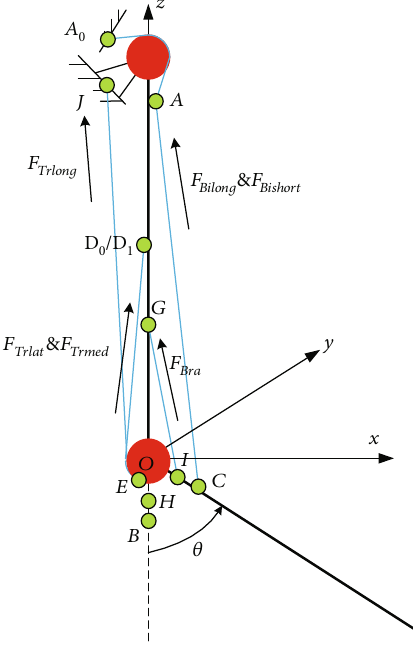
Figure 5: Schematic diagram of the improved musculoskeletal model of the elbow joint established in this paper.